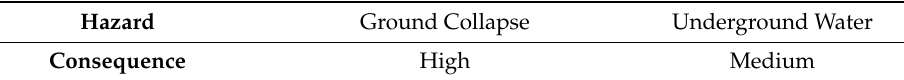
Table 6. The result of Query 2, in a tabular form.